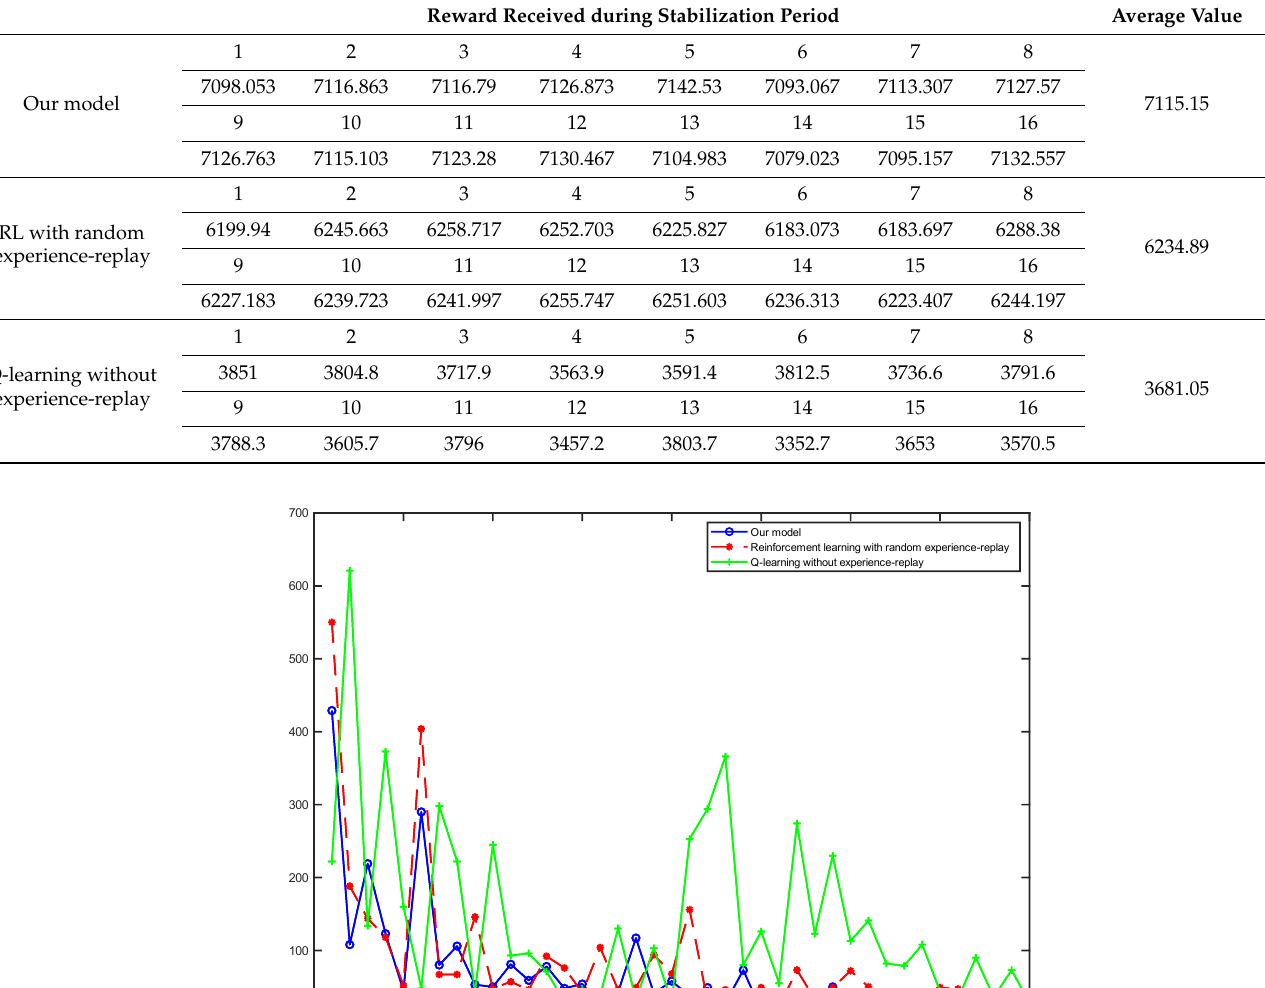
Table 2. Partial data intercepted within the stabilization interval and their averages.